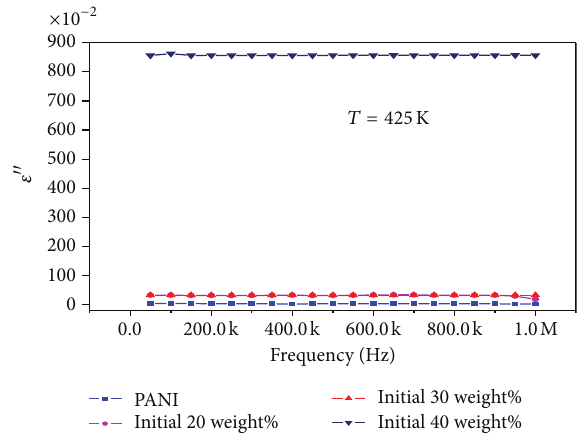
Figure 7: XRD of pure PANI and PANI/V 2 O 5 composites (different weight